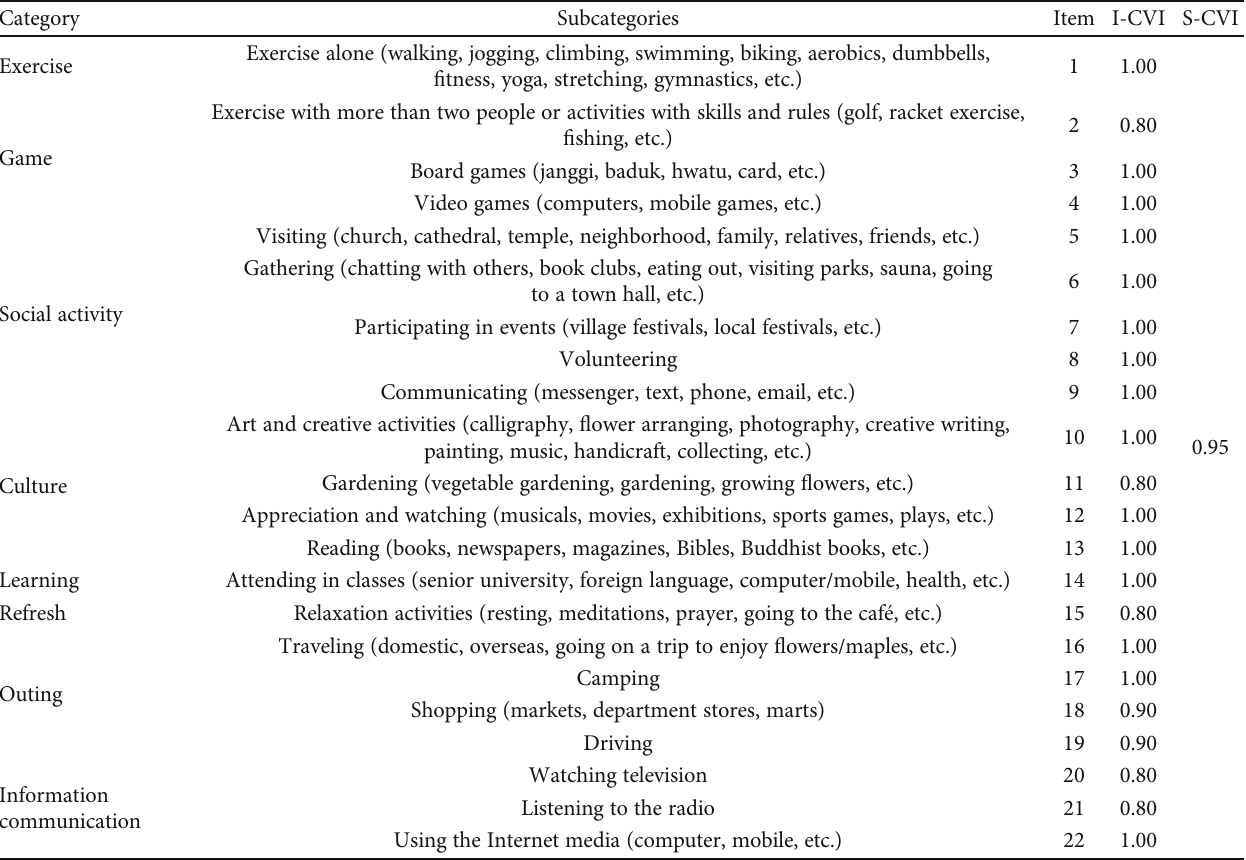
Table 5: The result of content validity ( N = 10